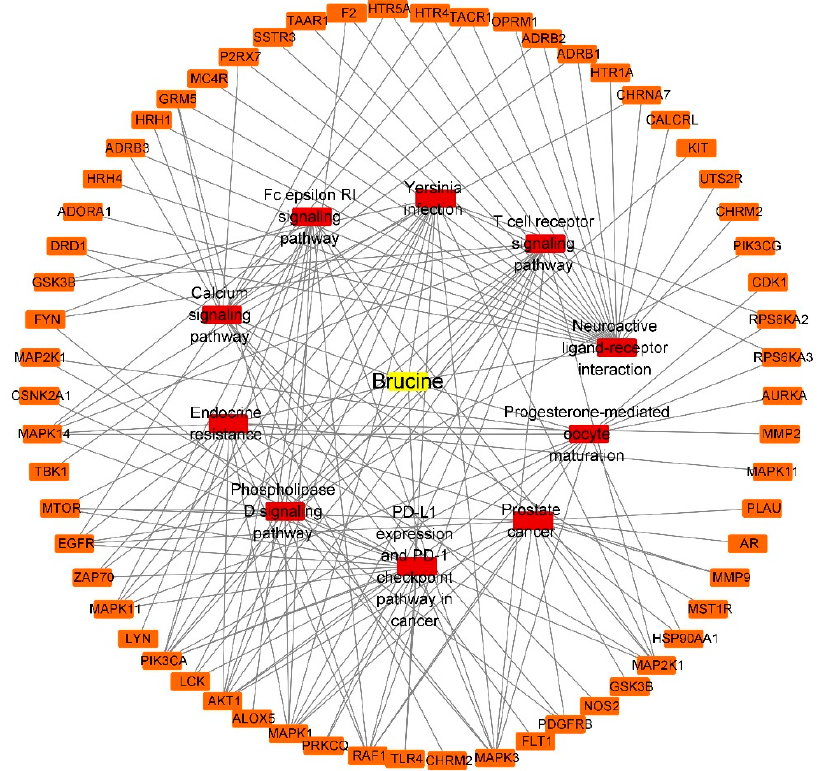
Figure 8. “Component-target-pathway” network of BRU (Yellow: compounds; red: pathways; orange: genes).